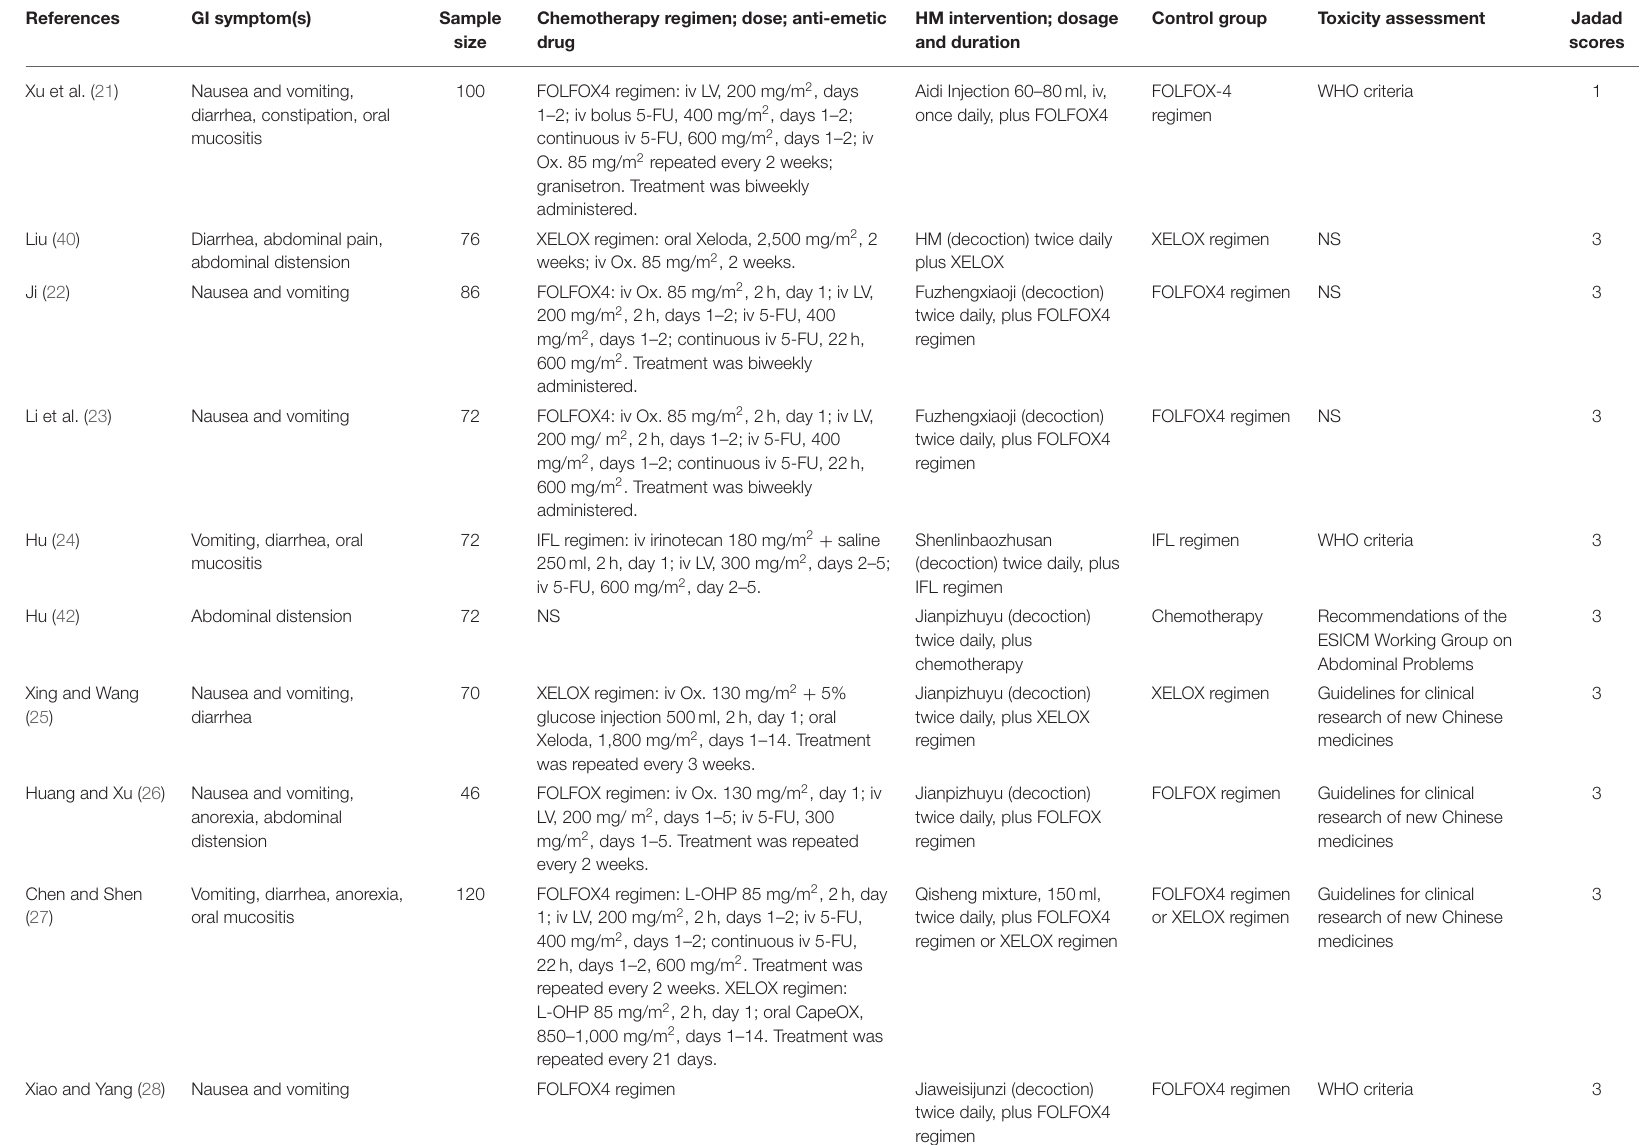
TABLE 1 | Characteristics of randomized controlled trials of HMs combined with chemotherapy for colorectal cancer with GI toxicity incidence as an